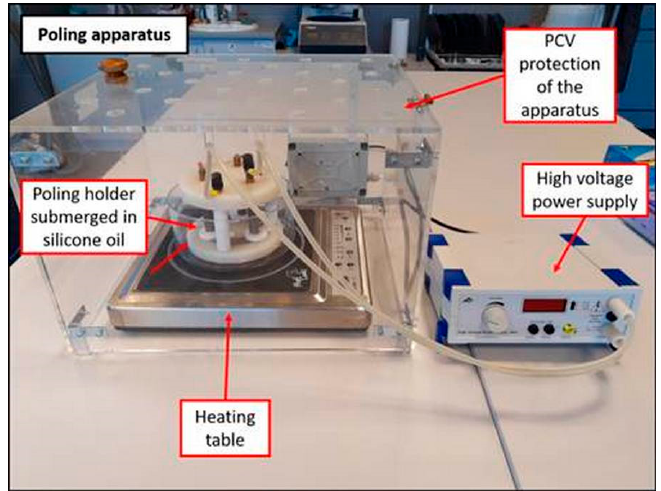
Figure 4. Prototype apparatus used for polarization of the manufactured piezoelectric beam.